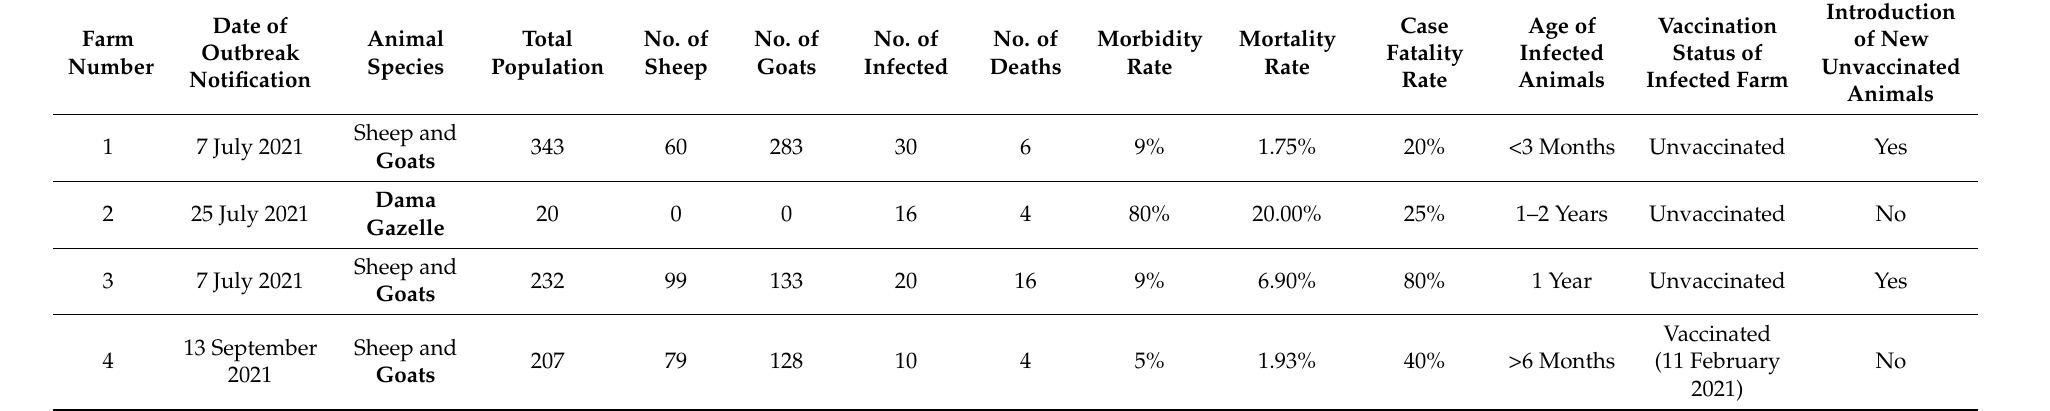
Table 2. The morbidity, mortality, case fatalities and vaccination history are shown. Animal species infected per each farm were shown in bold.